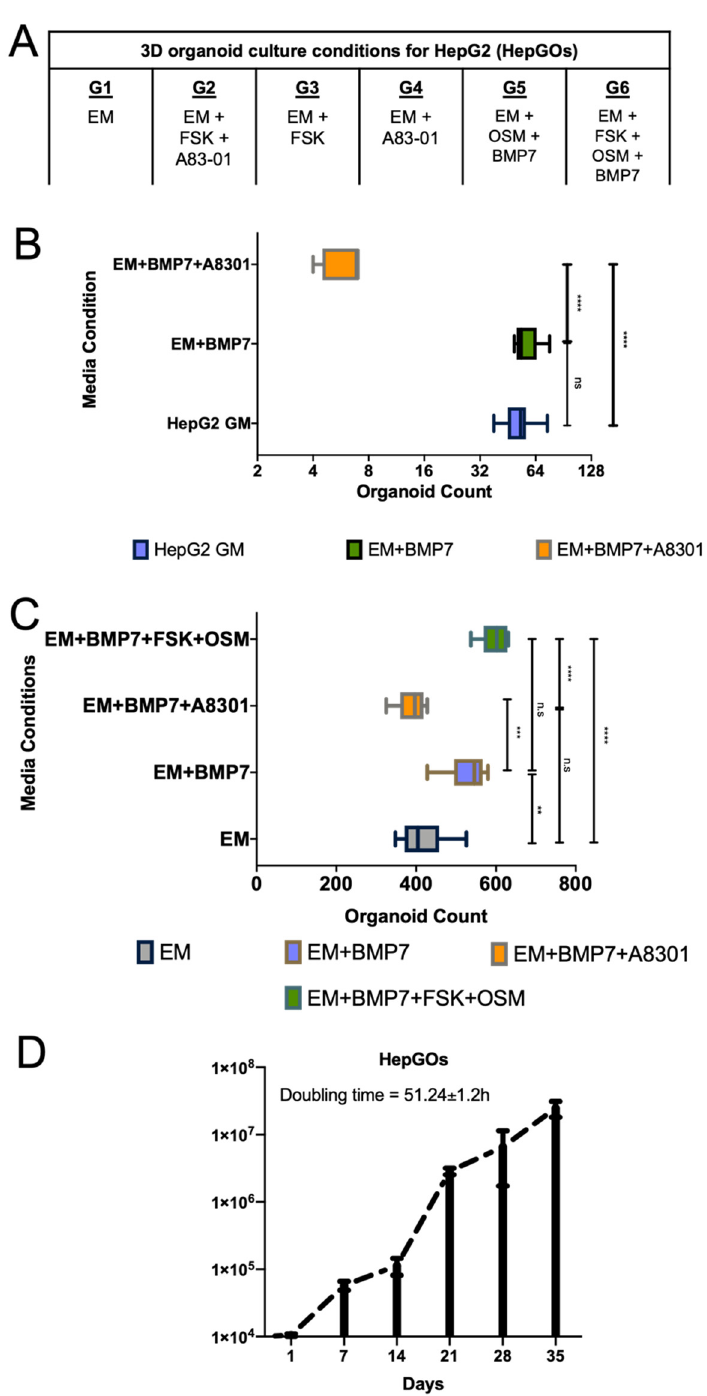
Figure 2. Expansion of HepG2 cells in 3D organoid cultures under different conditions. ( A ) Various EM with supplemental conditions, combined with differentiation in DM, for 3D culture of HepG2 cells to form HepGOs. ( B ) Counts of HepGOs derived using BMP7 and A8301 supplemented conditions, compared to regular HepG2 growth media (GM). ( C ) Counts of HepGOs organoids derived using various supplemented conditions. As expected, the number of organoids grown in conjunction with OSM and FSK is the highest when compared to the other conditions. ( D ) Proliferation rate of single cell-derived HepGOs and in vitro growth rate at the indicated time in optimized EM. Doubling time is indicated on days 21–28. Comparison of counts and conditions were determined by two-way ANOVA with Bonferroni post hoc test (**** p < 0.0001, *** p < 0.001, ** p < 0.01, ns, not significant).